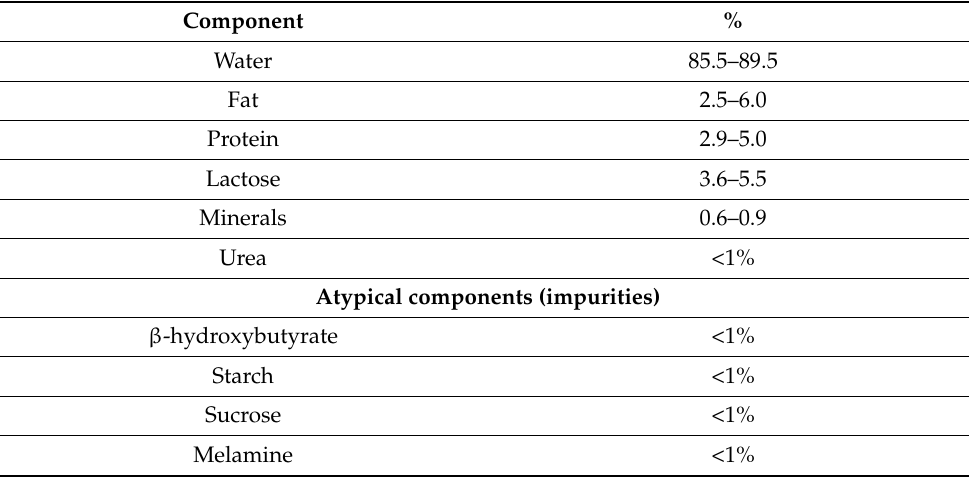
Table 2. Main components of cow milk (adapted from